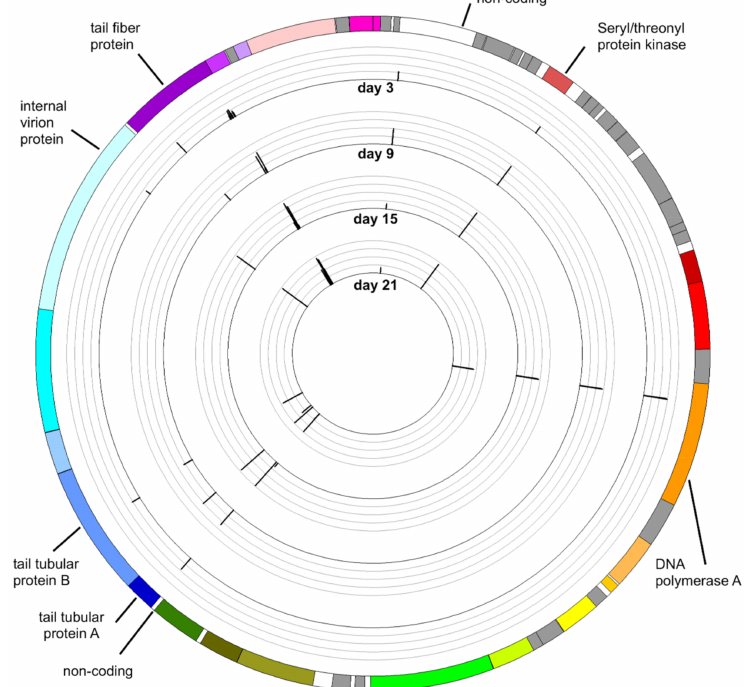
Figure 3. Variance from the reference genome of Aquamicrobium phage P14 over the course of the experiment. By each position at which the frequency of a mutation was higher than 10% of the mapped reads, a bar is shown to indicate the frequency (0–100%, grey line every 25%). Genes encoding hypothetical proteins are marked in grey while genes encoding proteins with an identified function are marked in color. The image was produced using Circos